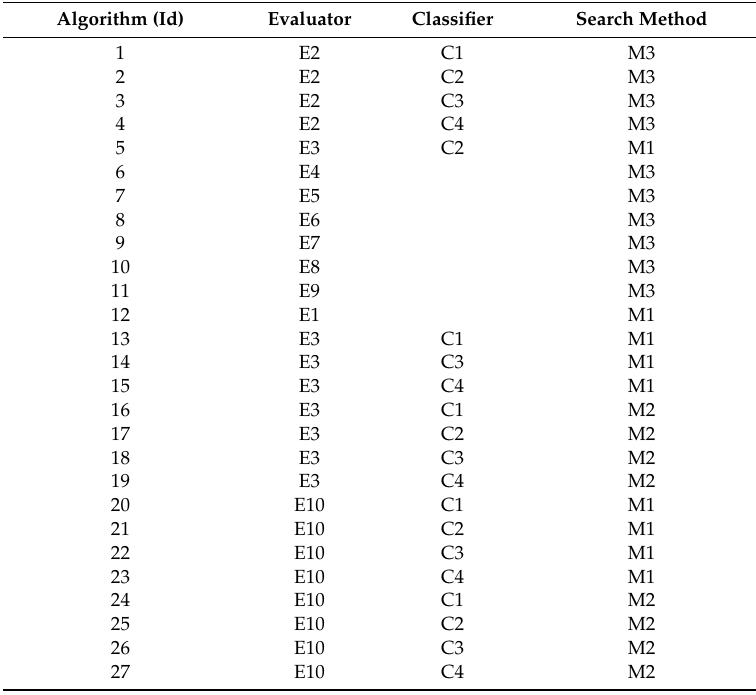
Table 1. List of algorithms created for the attributes’